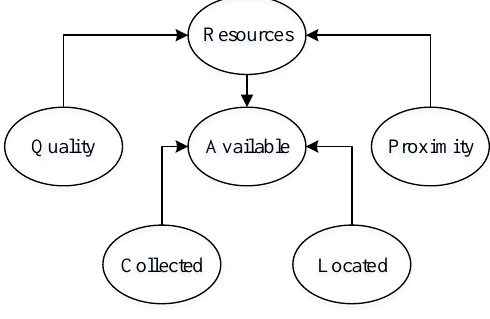
Figure 2. Mission resource characterization.